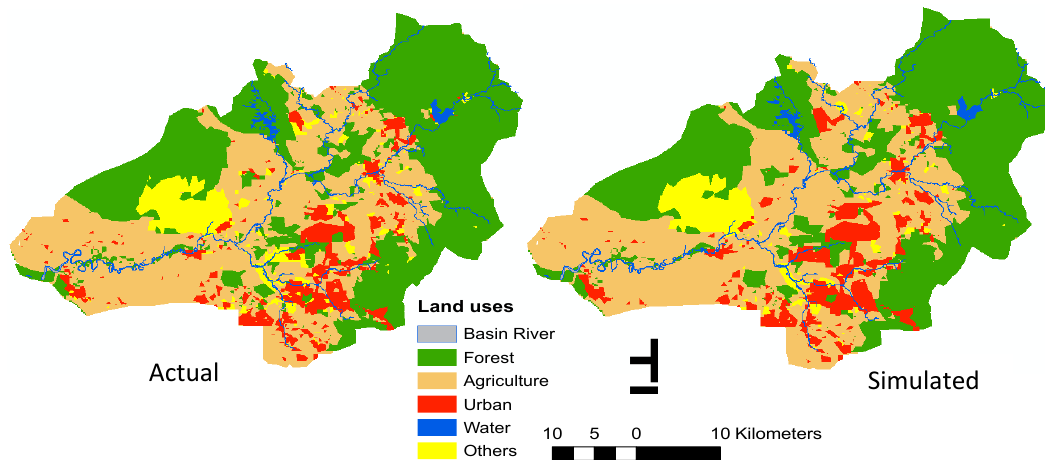
Fig. 5: The actual and simulated land use change in